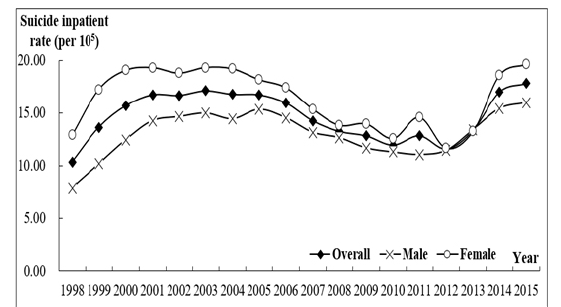
Fig. 2. The study population of hospitalizations following a survived suicide attempt in Taiwan from 1998 to 2015 (n =